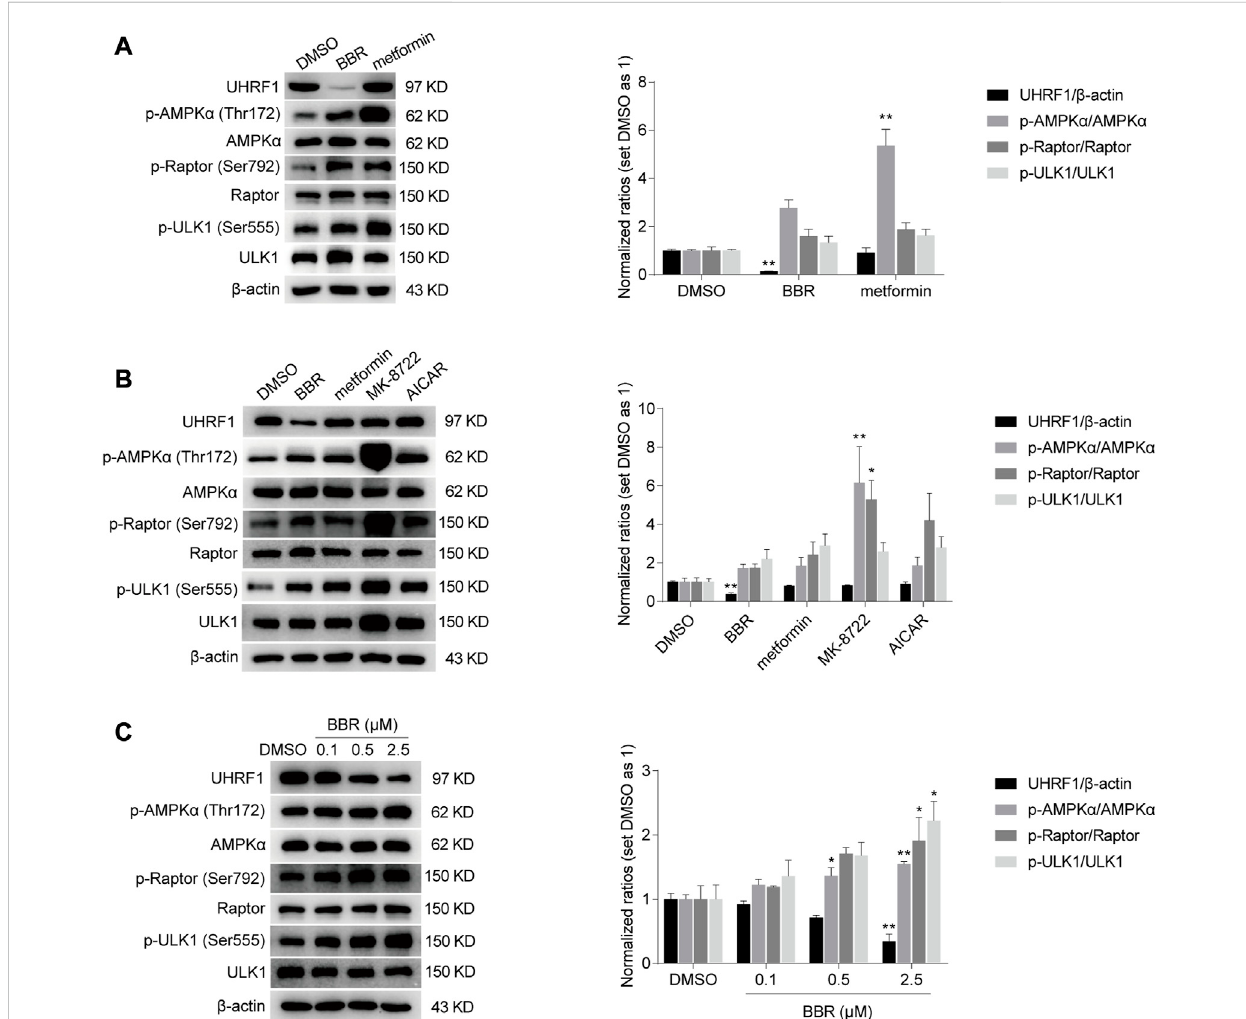
BBR, but not other AMPK activators such as metformin, MK-8722 and AICAR, reduced UHRF1 expression. BBR decreased UHRF1 expression, but metformindidnotevenatahighdoseof2 mM (A) .ThedirectactivatorsMK-8722andAICARdidnotin fl uenceUHRF1expression (B) .BBRdownregulated UHRF1 in a dose-dependent manner (C) . HCT-116 cells were treated with DMSO, BBR (2.5 μ M in panel A and B; 0.1 μ M, 0.5 μ M and 2.5 μ M in panel (C) , metformin (2 mM inpanel A; 250 μ Minpanel (B) ,MK-8722(10 μ M,panel (B) andAICAR(500 μ M,panel (B) for 20h,respectively. The ratioofDMSO treated group was set as 1. Values are expressed as the mean ± SEM of three independent experiments; * p < 0.05, ** p < 0.01 versus that of the vehicle (DMSO) treated